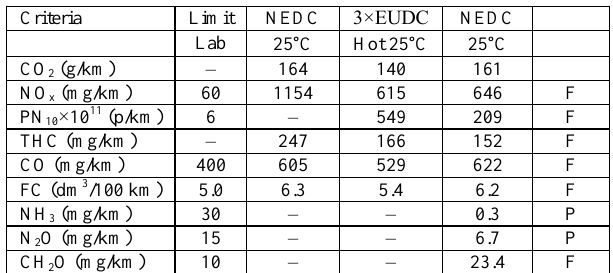
Table 2. Summary of results. F = Fail, P = Pass based on the Engine limits because the prototype vehicle was delivered for the Engine prize (Table 1) Criteria